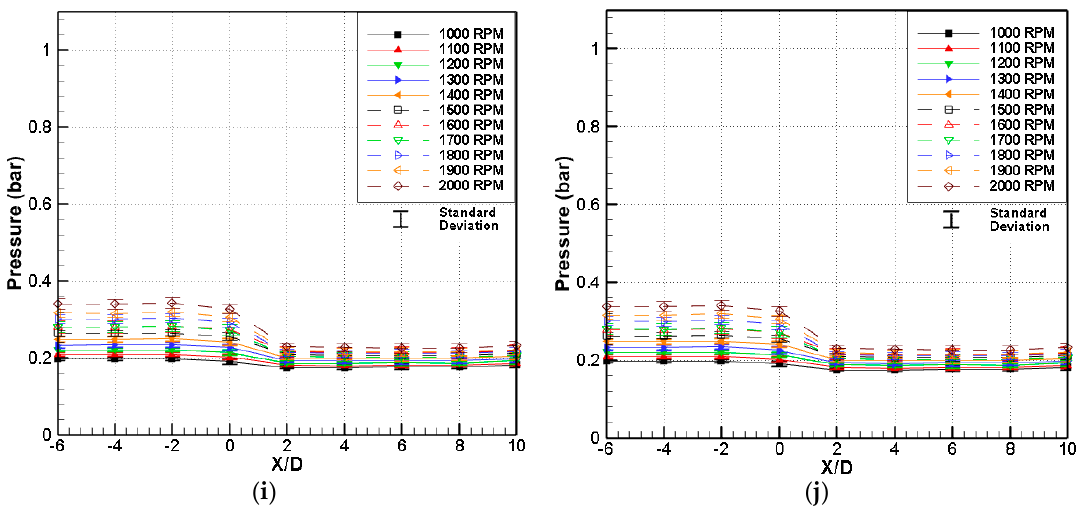
Figure 4. Pressure distribution along the pipeline. ( a ) 10% opening. ( b ) 20% opening. ( c ) 30% opening. ( d ) 40% opening. ( e ) 50% opening. ( f ) 60% opening. ( g ) 70% opening. ( h ) 80% opening. ( i ) 90% opening. ( j ) 100% opening.